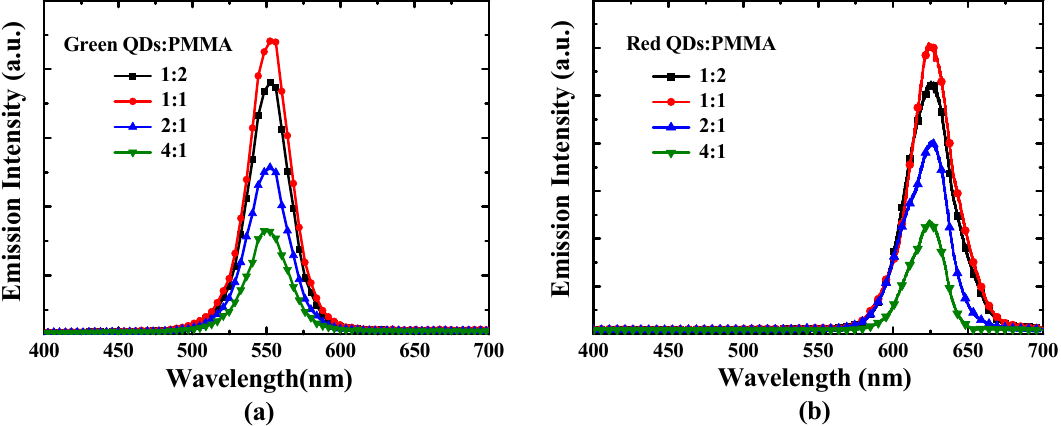
Figure 3. The emission spectra of various ( a ) green core-shell quantum dots: poly (methyl methacrylate) (QDs:PMMA) ratios and ( b ) red QDs:PMMA ratios excited by a tunable laser with a wavelength of 451 nm.